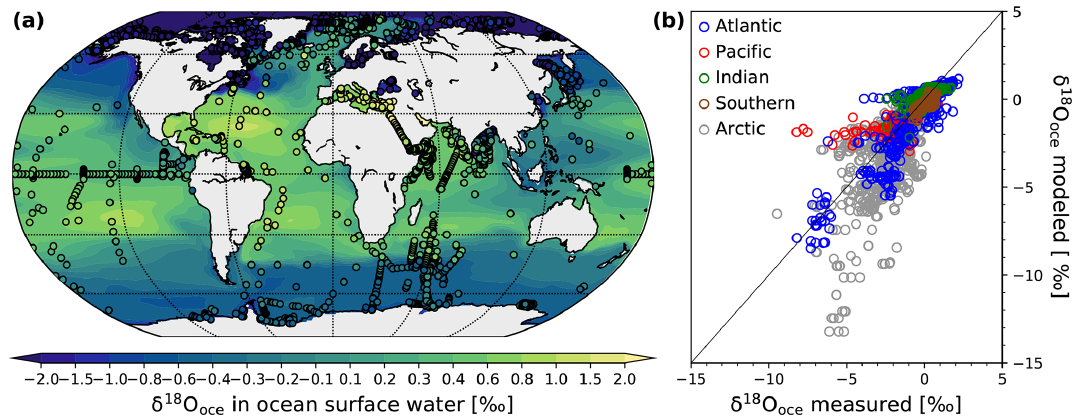
Figure 2. (a) Comparison of the global distribution of simulated (background pattern) annual mean δ 18 O oce values in ocean surface water (mean over the first 10m of depth) under PI conditions with observed δ 18 O oce values of the GISS database (colored dots). (b) Scatter plot of observed vs. modeled δ 18 O oce values for the Atlantic (blue circles), Pacific (red circles), Indian (green circles), Southern (brown circles) and Arctic Ocean (grey circles). The month of sampling has been considered for this scatter